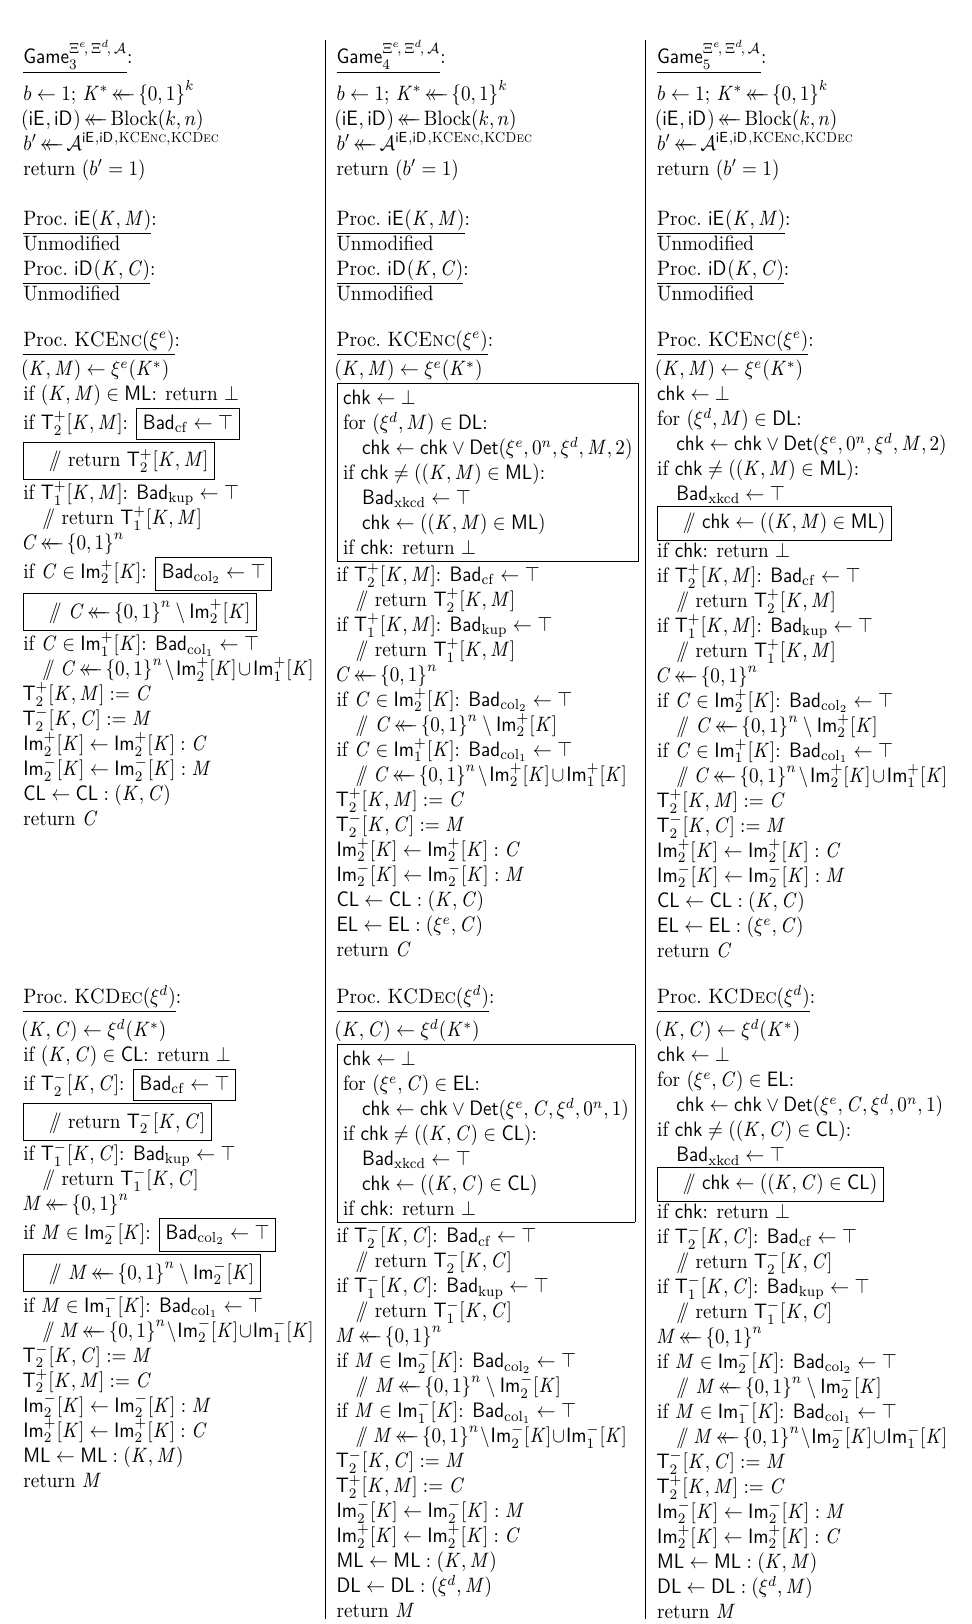
Figure 6: Game 3 , Game 4 , and Game 5